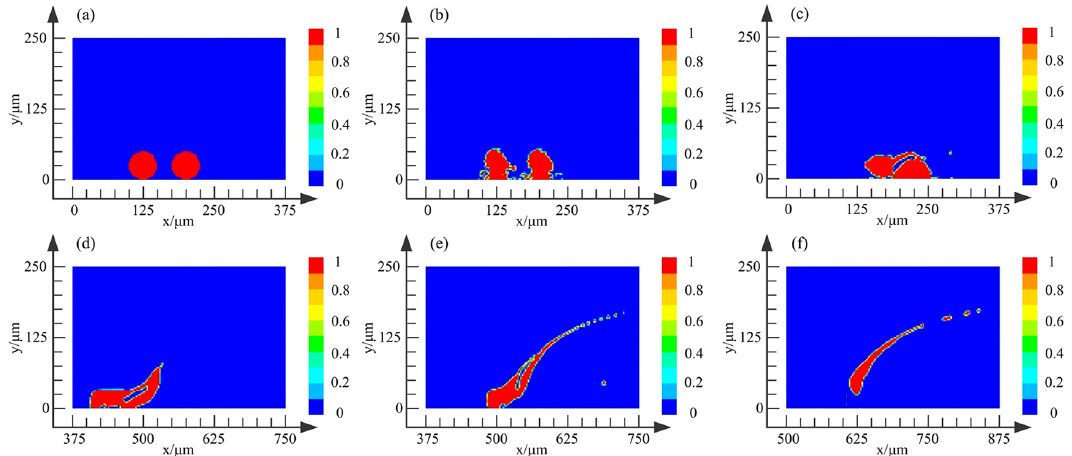
Figure 14. Volume fractions profiles of double parallel bubbles bursting on the wall: ( a ) t = 0 µ s, ( b ) t = 15 µ s, ( c ) t = 65 µ s, ( d ) t = 270 µ s, ( e ) t = 300 µ s, ( f ) t = 330 µ s.